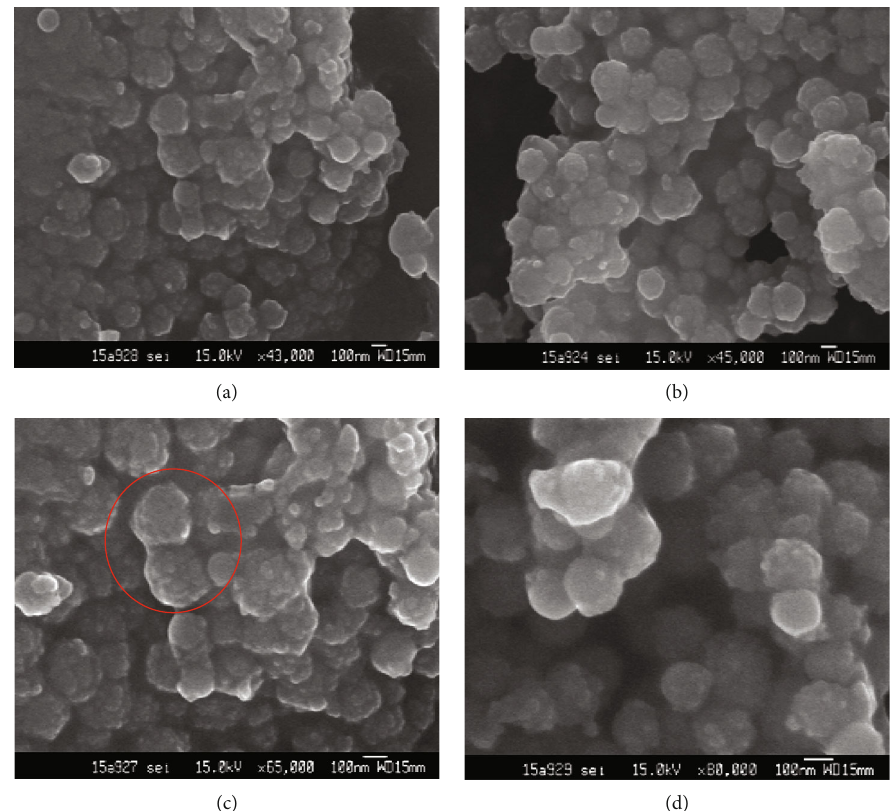
Figure 2: SEM images of (a – d) SiO SiO @PPy 2